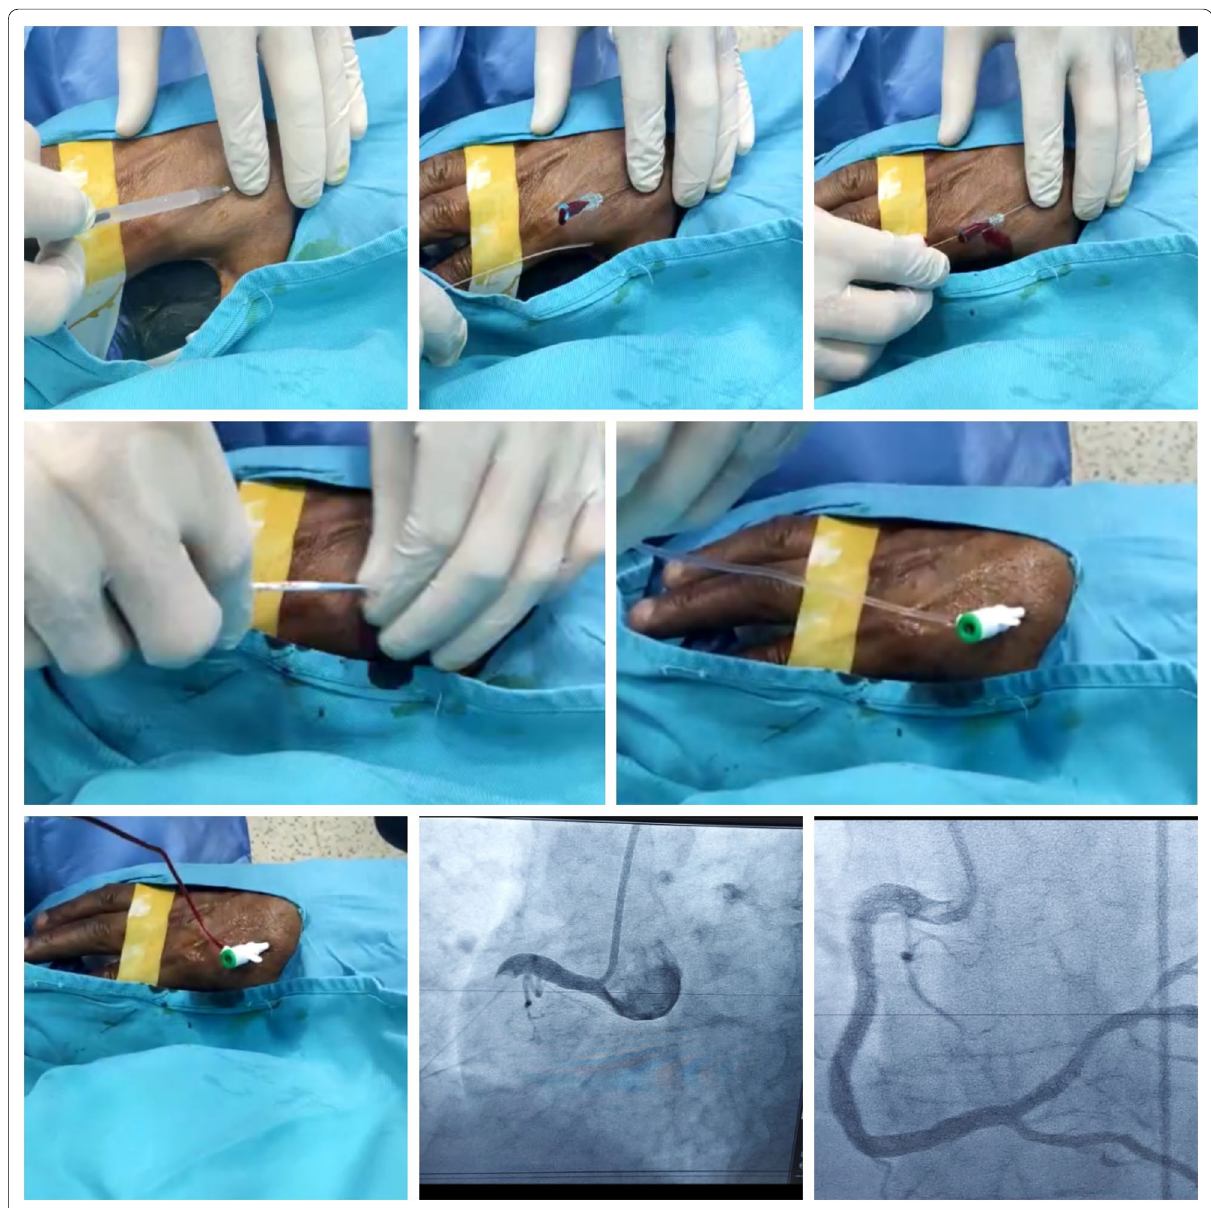
Table 7: No. of catheters used in group I shows that 23 (46.0%) used 2 catheters and 27 (54.0%) used 3 cath- eters, while in group II 27 (54.0%) used 2 catheters and 23 (46.0%) used 3 catheters. There were no statistically sig- nificant differences between groups where P